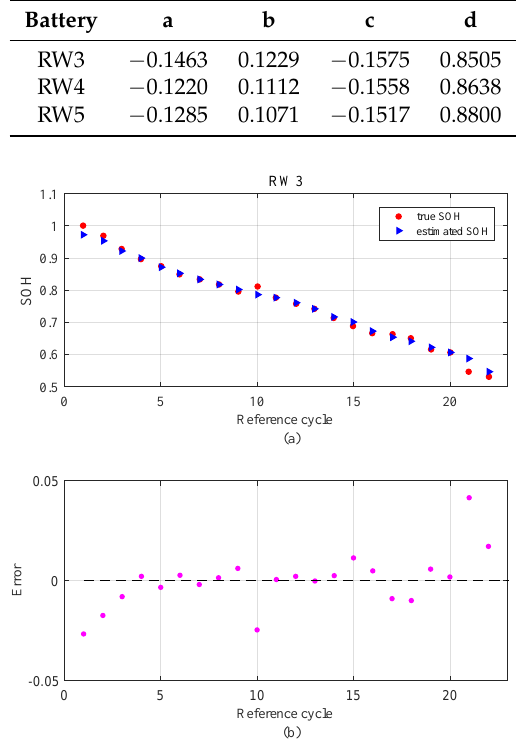
Figure 10. ( a ) The model fit of battery RW3, and ( b ) the error of the model fit.